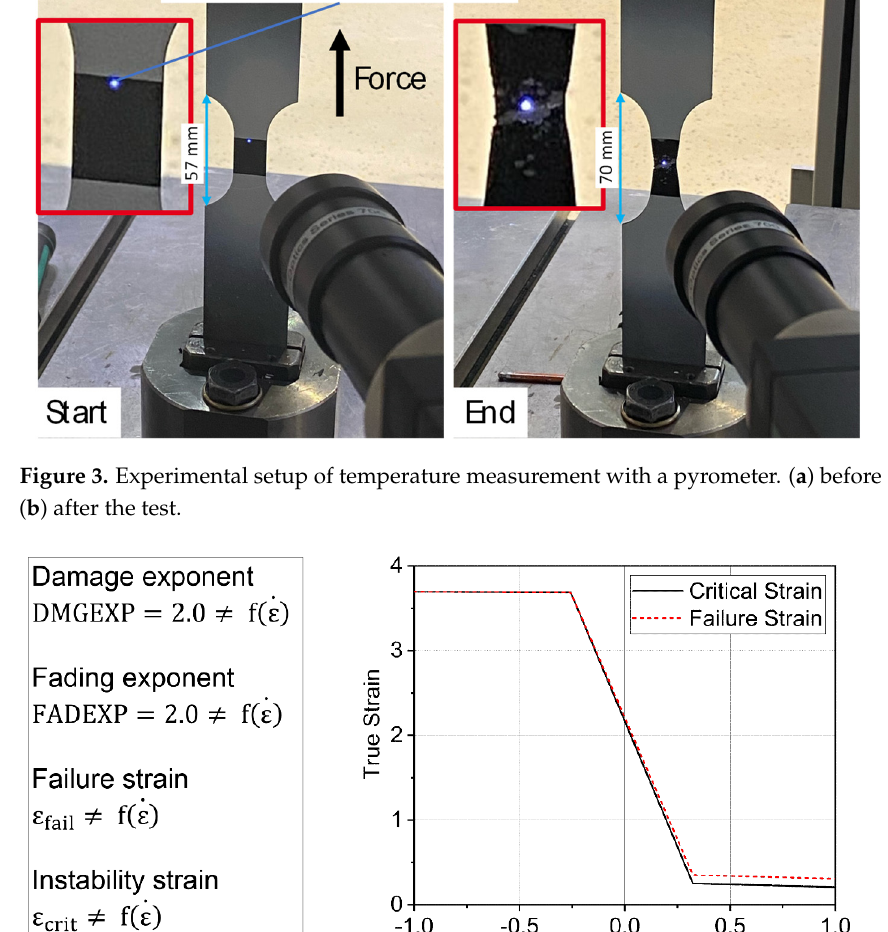
Figure 3. Experimental setup of temperature measurement with a pyrometer. ( a ) before the test and ( b ) after the test